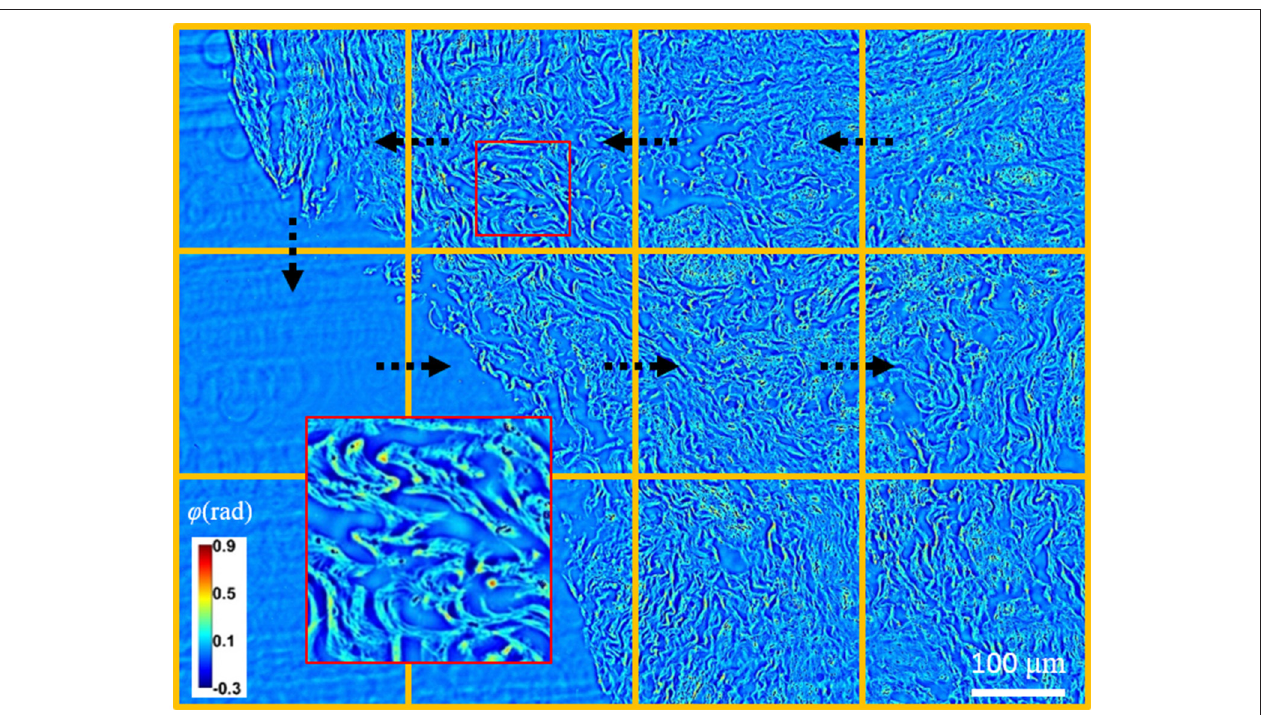
FIGURE 2 | By employing a translating stage, an unstained tissue slide can be scanned in real-time with great